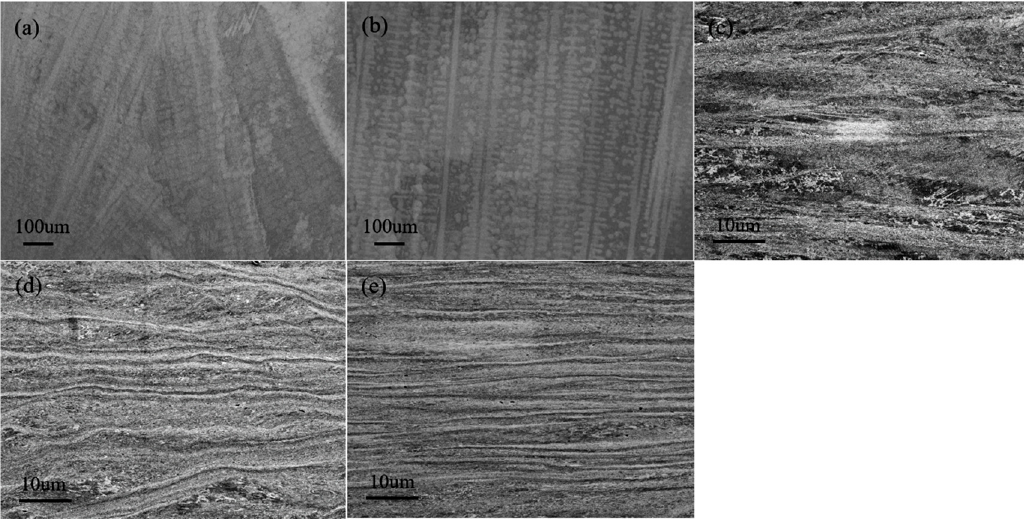
Figure 3. SEM micrographs of specimens treated with different rolling processes: ( a ) as-cast specimen, ( b ) solid solution specimen, ( c ) rolled specimen with a 75% reduction, ( d ) rolled specimen with an 85% reduction, and ( e ) rolled specimen with a 95% reduction.